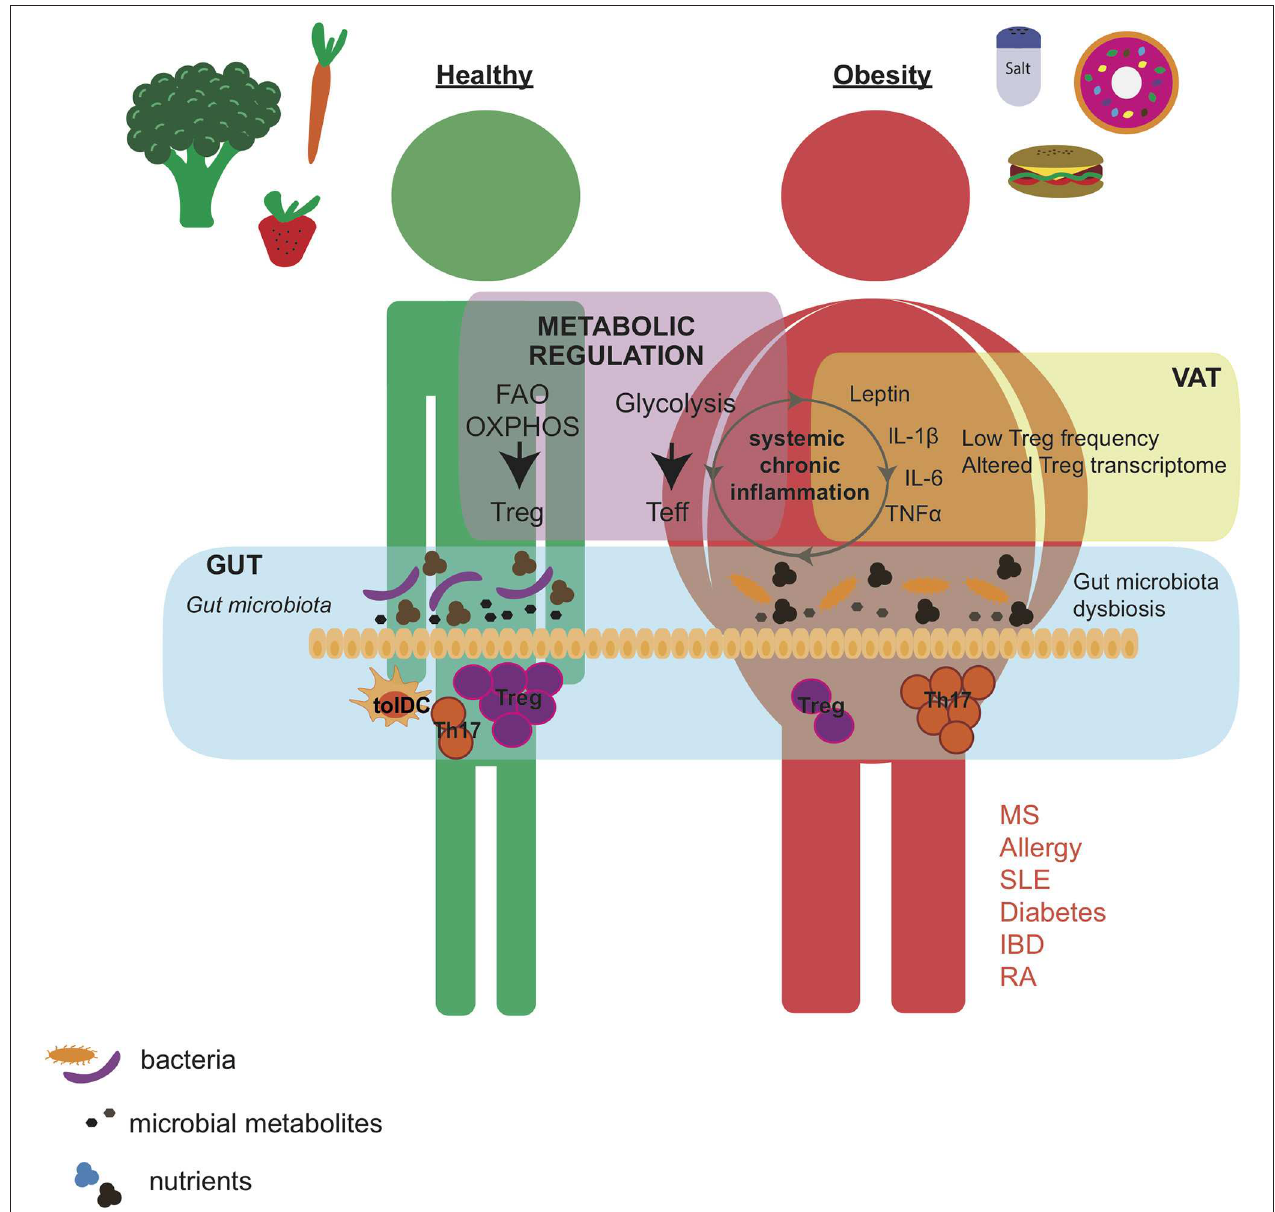
FIGURE 1 | Western diet affects gut microbial composition and induces low-degree chronic inflammation that alters the metabolic status of the individual. Healthy diet supports the growth of bacterial species that, by the production of immunomodulatory metabolites, promotes Treg induction over Th17 cell development in the intestine. By contrast, western diet, characterized by high caloric intake, and high levels of salt and cholesterol, leads to obesity, increased secretion of pro-inflammatory adipokines and cytokines, and altered gut microbial composition. These changes are associated with an altered Treg phenotype and higher Th17 cell differentiation in the VAT and intestine. Importantly, Treg and Teff cells developed in the gut and VAT have a systemic effect and may contribute to exacerbation of autoimmune pathogenicity. Moreover, the frequency and function of Tregs may also be regulated by metabolic pathways such as FAO, OXPHOS, and glycolysis that depend on the nutritional state of the individual. VAT, visceral adipose tissue; Teff, effector T cell; FAO, fatty acid oxidation; OXPHOS, oxidative phosphorylation; MS, multiple sclerosis; SLE, systemic lupus erythematosus; IBD, inflammatory bowel disease; RA, rheumatoid arthritis.